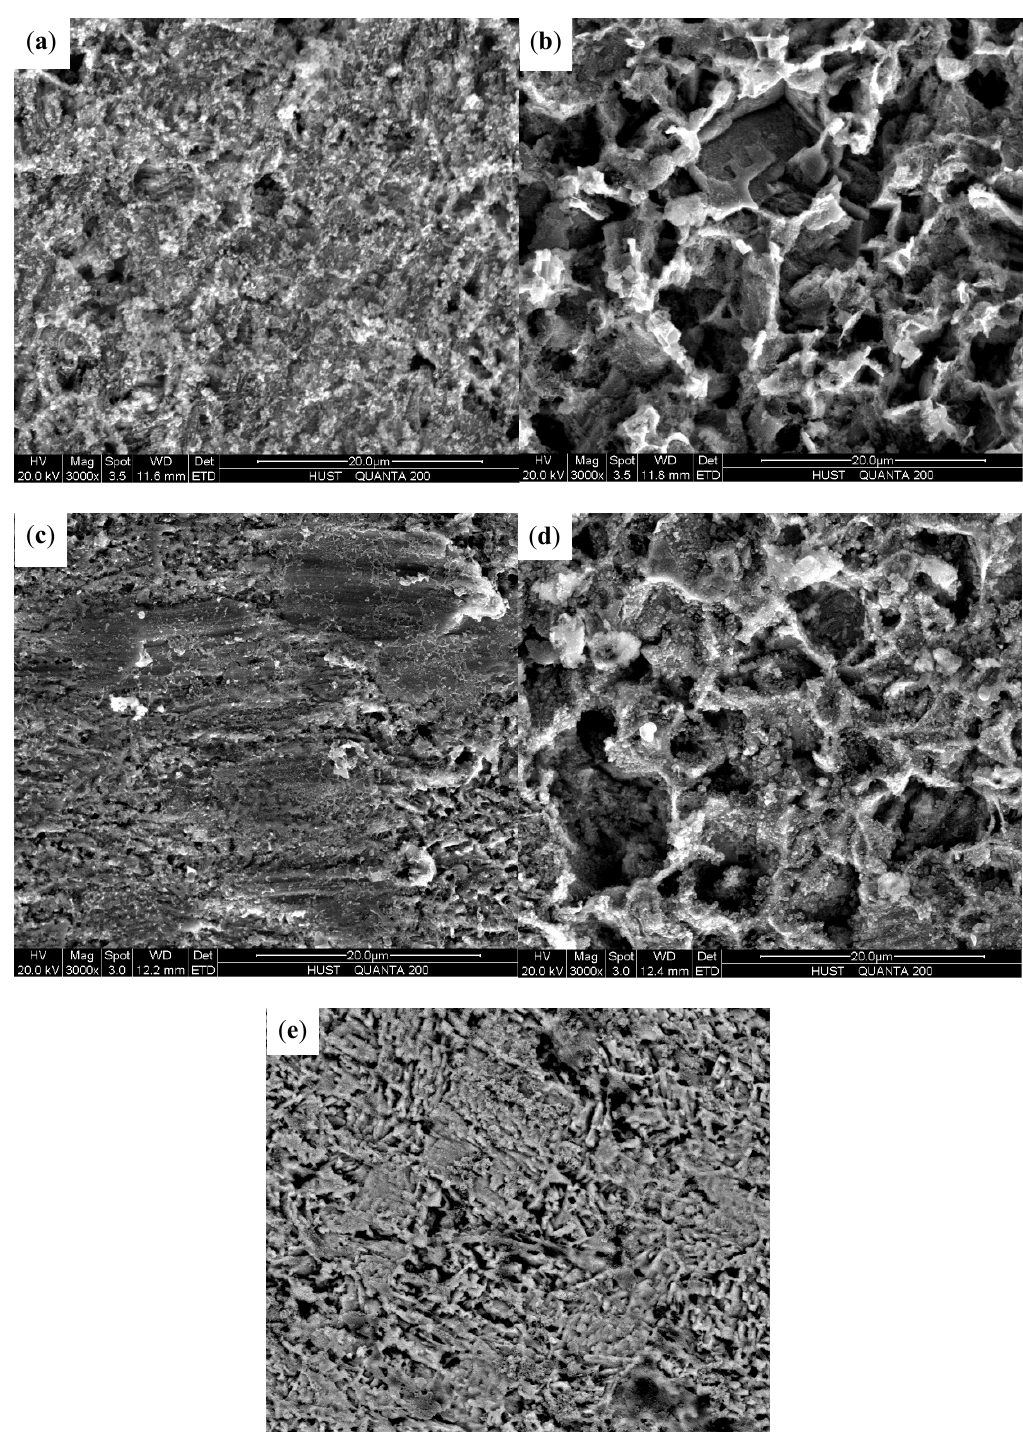
Figure 8. SEM surface morphologies of electrodes under flow and static conditions: ( a ) electrode 6 (outside), FAC test; ( b ) electrode 14 (inside), FAC test; ( c ) electrode 6 (outside), E-C test; ( d ) electrode 14 (inside), E-C test; ( e ) under static-state conditions.